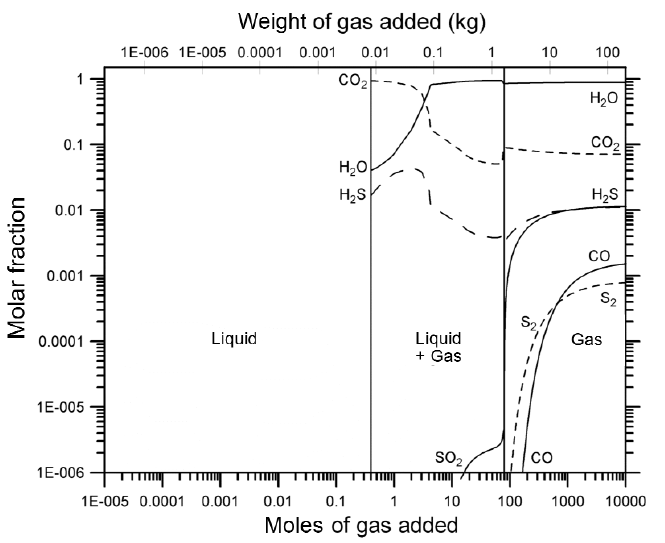
Fig. 11. Variations in the molar fractions of H 2 O ( g ) , CO 2( g ) , H 2 S ( g ) , SO 2( g ) , CO ( g ) , and S 2( g ) , during the progres- sive addition of hot (915°C) magmatic gas into 1000 g of pure water initially at 25°C. Pressure was kept at 0.1 MPa throughout the simulation.